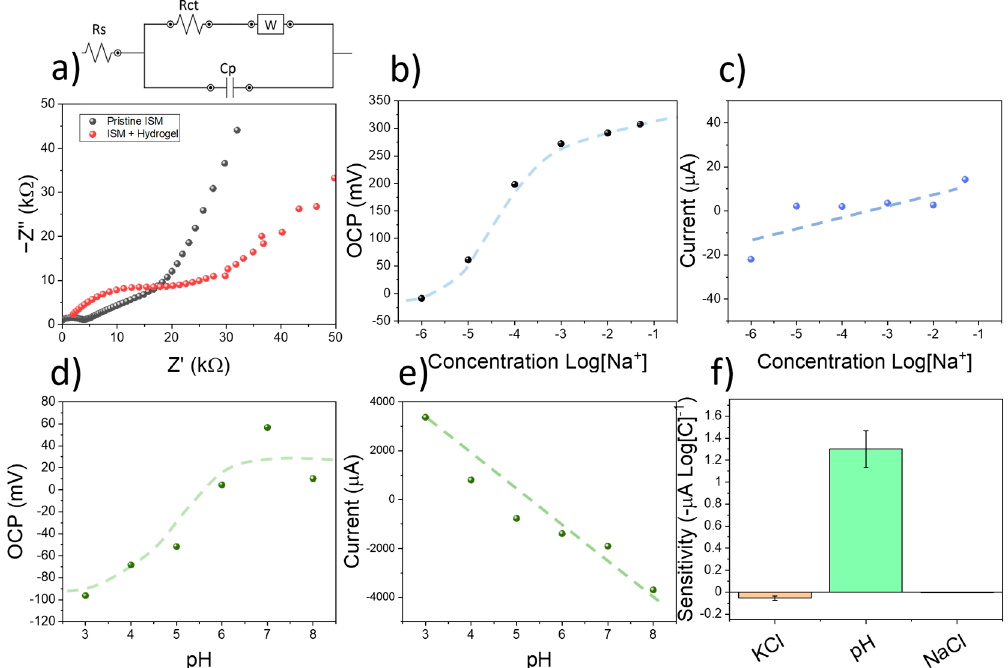
Figure 3. ( a ) Impedance spectroscopy plot of pristine ISM, and ISM where an alginate/acrylamide hydrogel film had been placed. The equivalent circuit employed for simulation is indicated. ( b ) OCP calibration plot of screen-printed electrodes using KCl. ( c ) Results from current obtained on the RuOx-modified copper electrodes during the measurement process. ( d ) OCP calibration plot obtained after calibrating the sensing devices using KOH. ( e ) The current obtained during the measurement process due to the applied voltage is indicated. ( f ) Comparison chart between the current sensitivities obtained at different concentration of electrolytes. The error bars represent the standard errors from the linear regression plots.